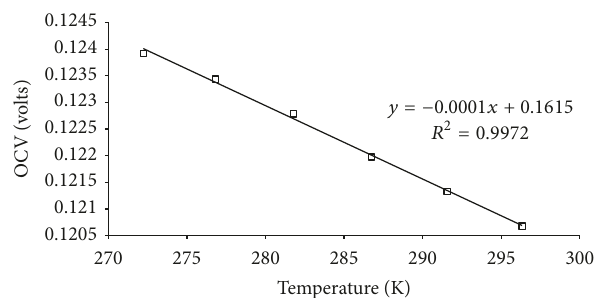
Figure 3: Plot of temperature (K) versus OCV (volts).